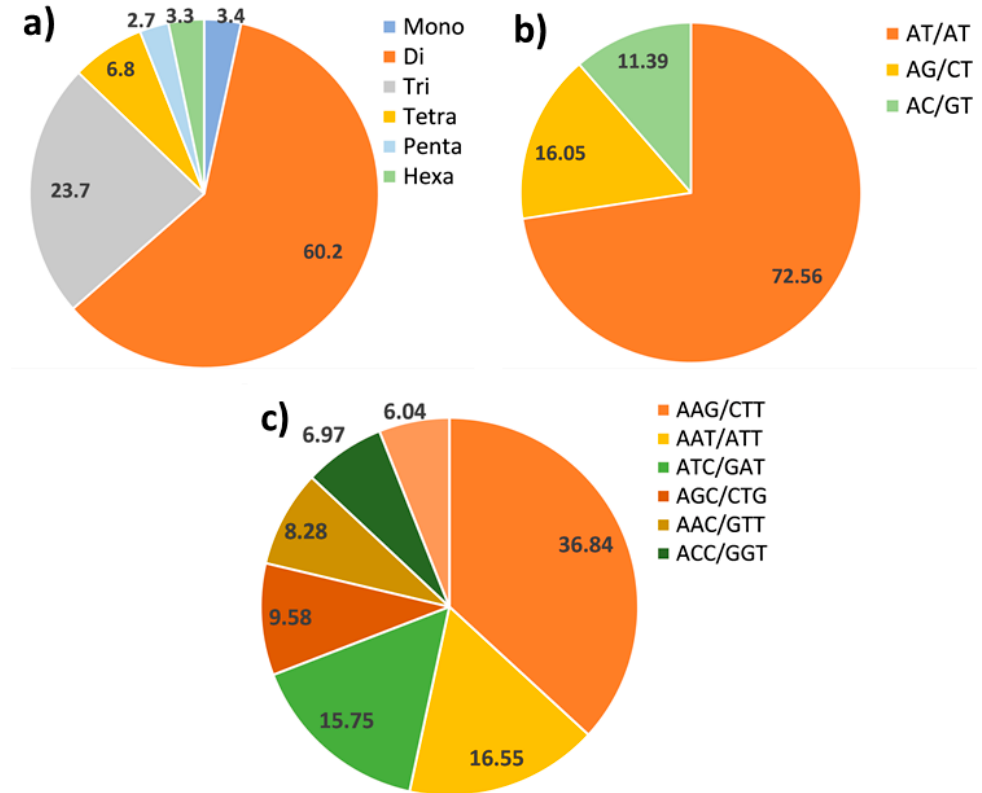
Figure 1. Microsatellites distribution in the poppy anemone genome. ( a ) Percentage distribution of the most frequent classes of SSRs; ( b ) dinucleotides motifs e and ( c ) main trinucleotides motifs identified by SciRoKo.